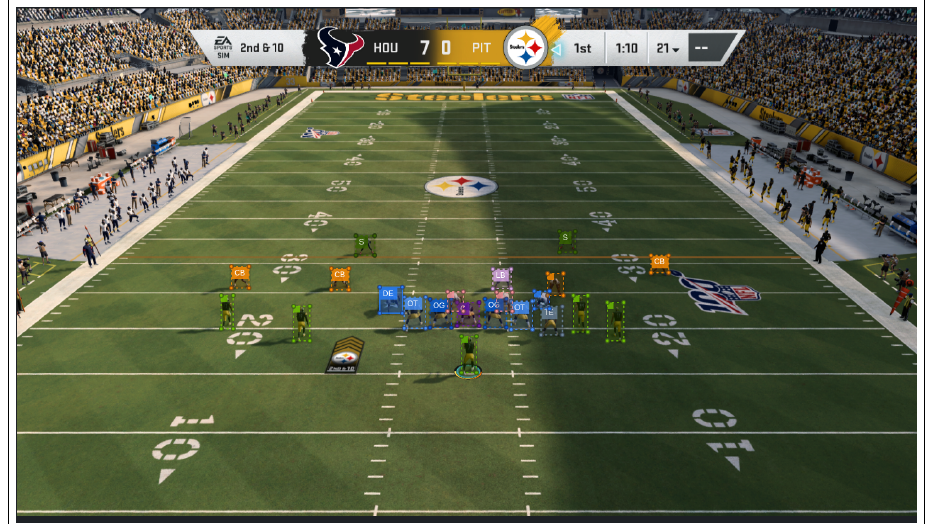
Figure 5. Annotated Data. Using the Microsoft Visual Object Tracking Tool (VOTT), we manually labeled the individual